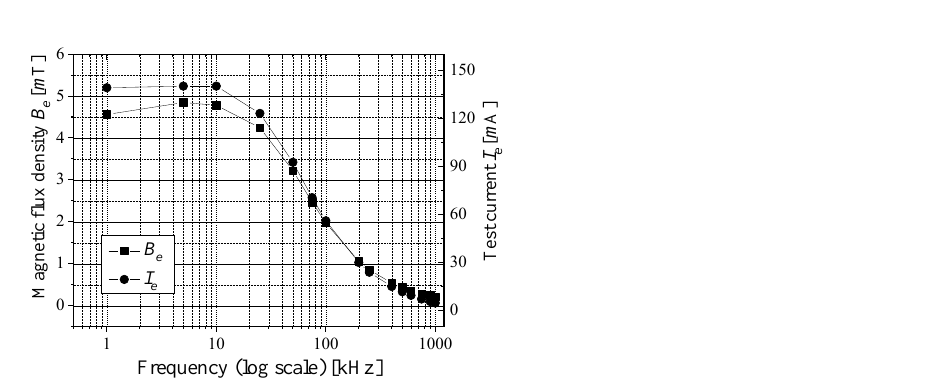
Figure 5. Calculated and LCR measurement results of the inductance for three different core materials.